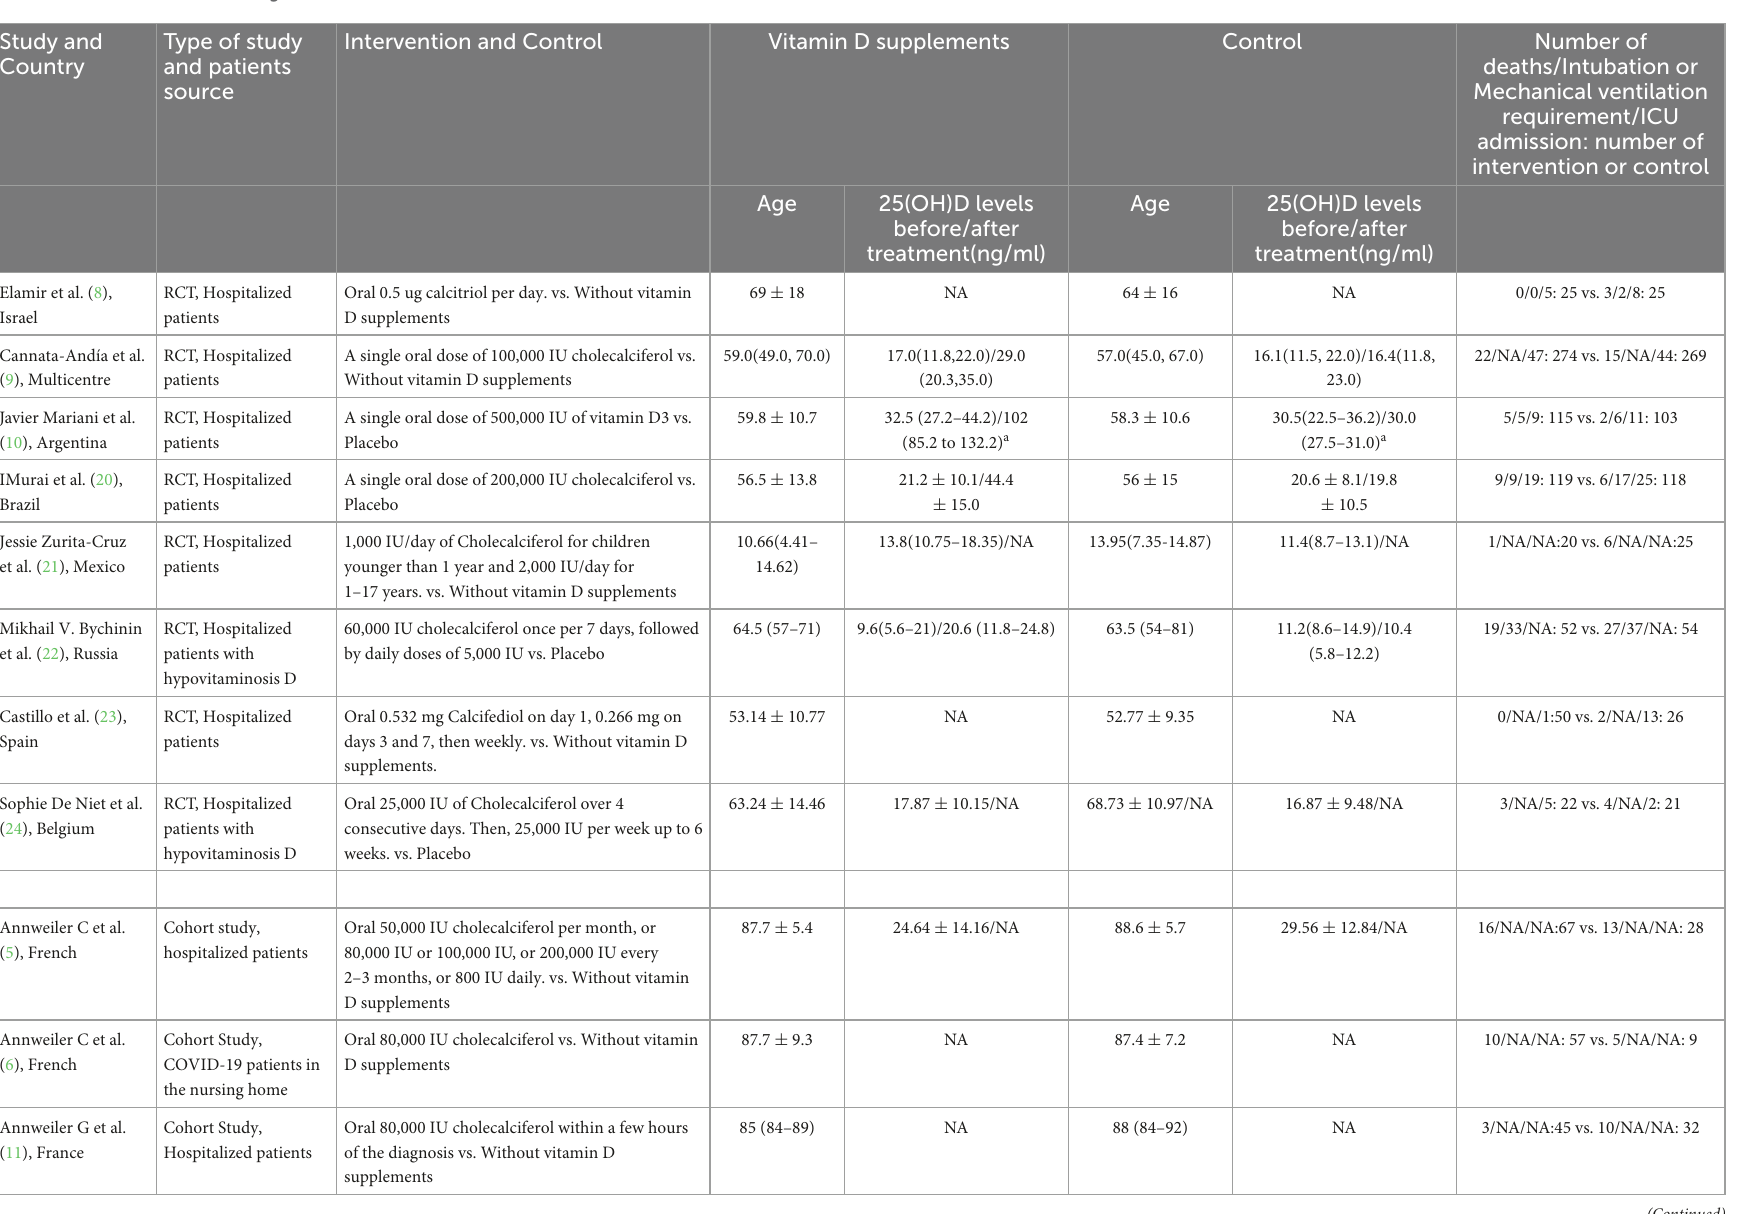
TABLE 1 The characteristics of eligible